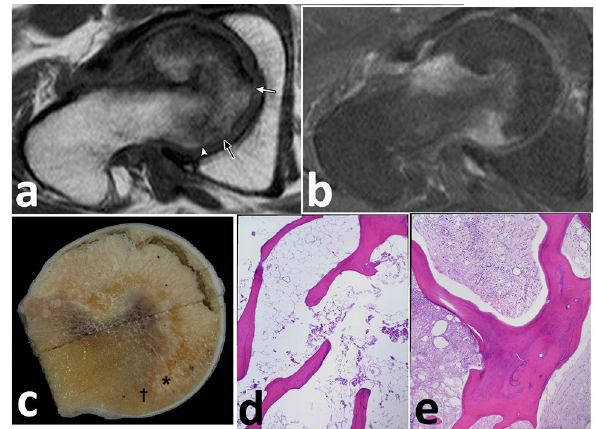
Figure 6. A 52-year-old male with a history of alcohol abuse. ( a ) The posterior boundary of the necrotic lesion on unenhanced oblique-axial T1 image (TR/TE = 500/18 ms) is unclear ( white arrow , black arrow , or arrowhead ) due to the BME (BME grade II). ( b ) The precise boundary of the necrotic lesion is determined by contrast-enhanced T1 image (TR/TE = 700/18). ( c ) Cut section of the resected femoral head shows yellowish- white necrotic lesion, corresponding to the unenhanced lesion on contrast-enhanced MR image (b ). ( d ) The histopathological appearance of the necrotic legion (* in c ), which demonstrates the accumulation of bone marrow cell debris, and the bone trabeculae with empty lacunae beneath the fracture line (haematoxylin and eosin stained; H&E, original magnification 40 ×). ( e ) Repair tissue is found in the viable zone († in c ), including vascular granulation tissue, fibrous tissue, and appositional bone (H&E, 40